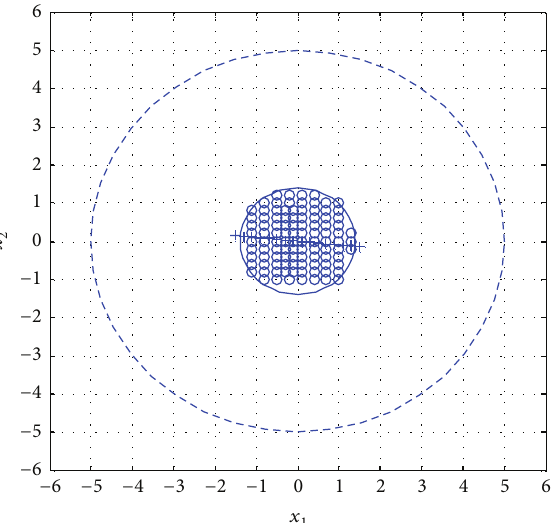
Figure 5: State response and minimum bound by Theorem